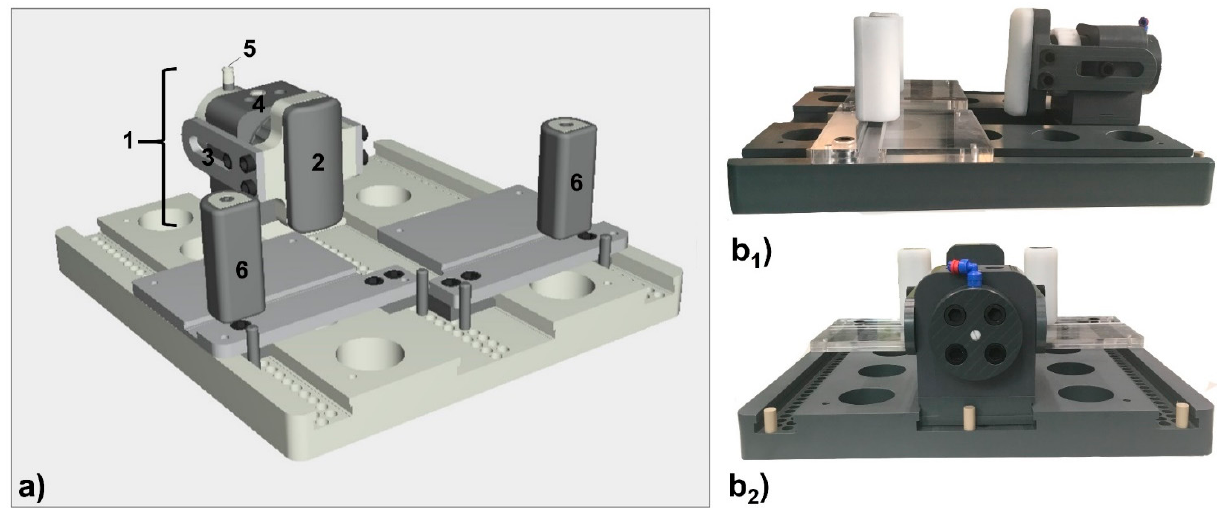
Figure A1. Loading unit of the MRI-compatible pressure-controlled loading device. ( a ) Schematic visualization of the components. (1) Pneumatic mechanism, (2) padded pressure applicator, (3) safety rails, (4) encasement, (5) pressure port, (6) padded counter-bearings. ( b ) Unloaded device as viewed from the side ( b 1 ) and the rear ( b 2 ).